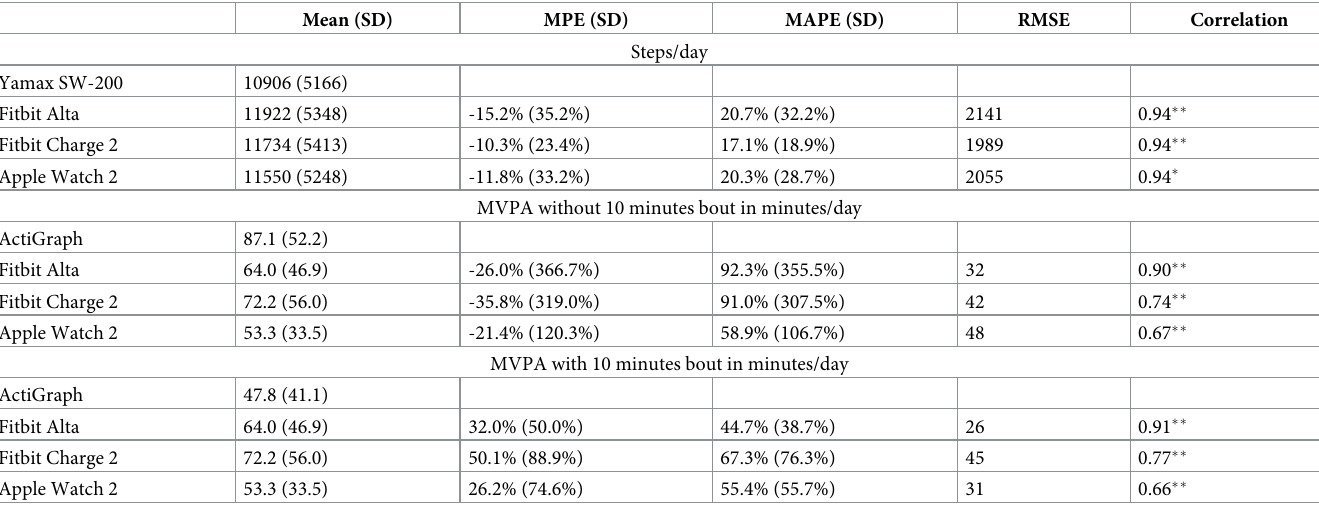
Table 2. Validity of steps and moderate-to-vigorous minutes estimation from three consumer monitors and two research monitors ( N = 48). Mean (SD) RMSE